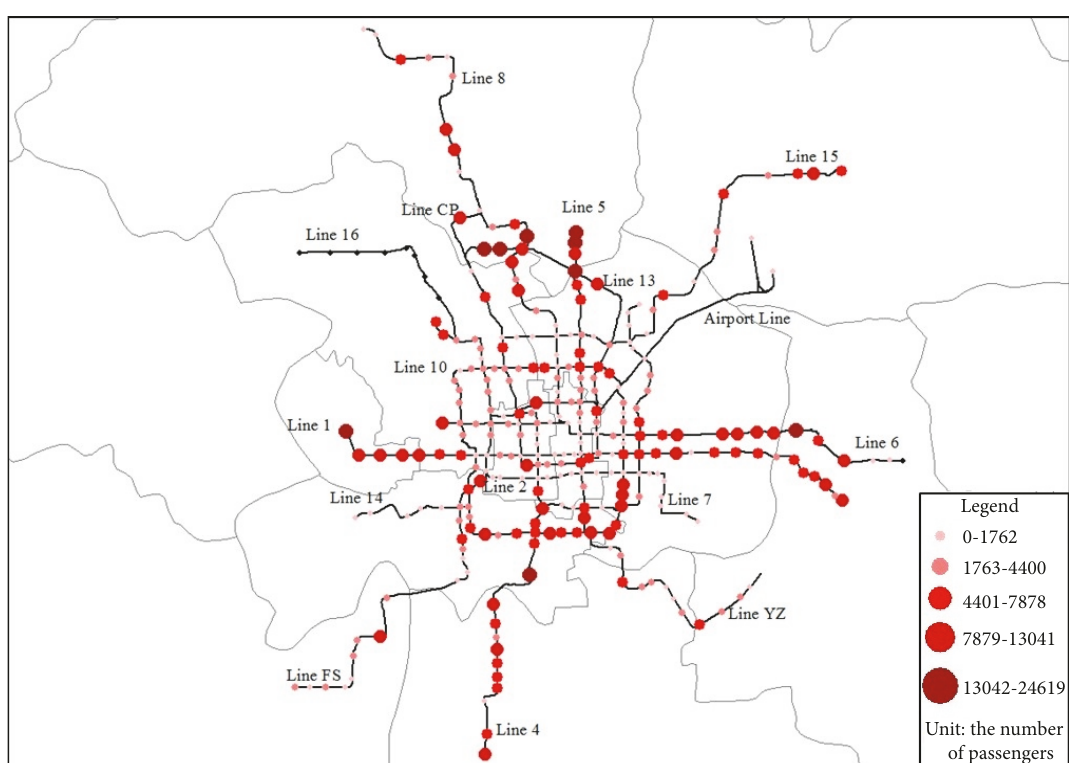
Figure 12: Distribution of potentially influenced passengers for the discount fare.